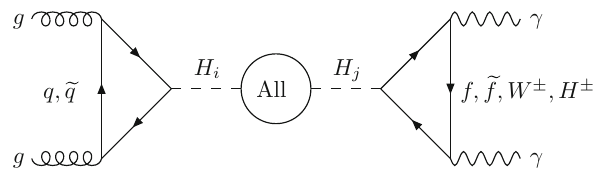
Fig. 1 Illustration of the effect of mixing in the propagator induced by quantum